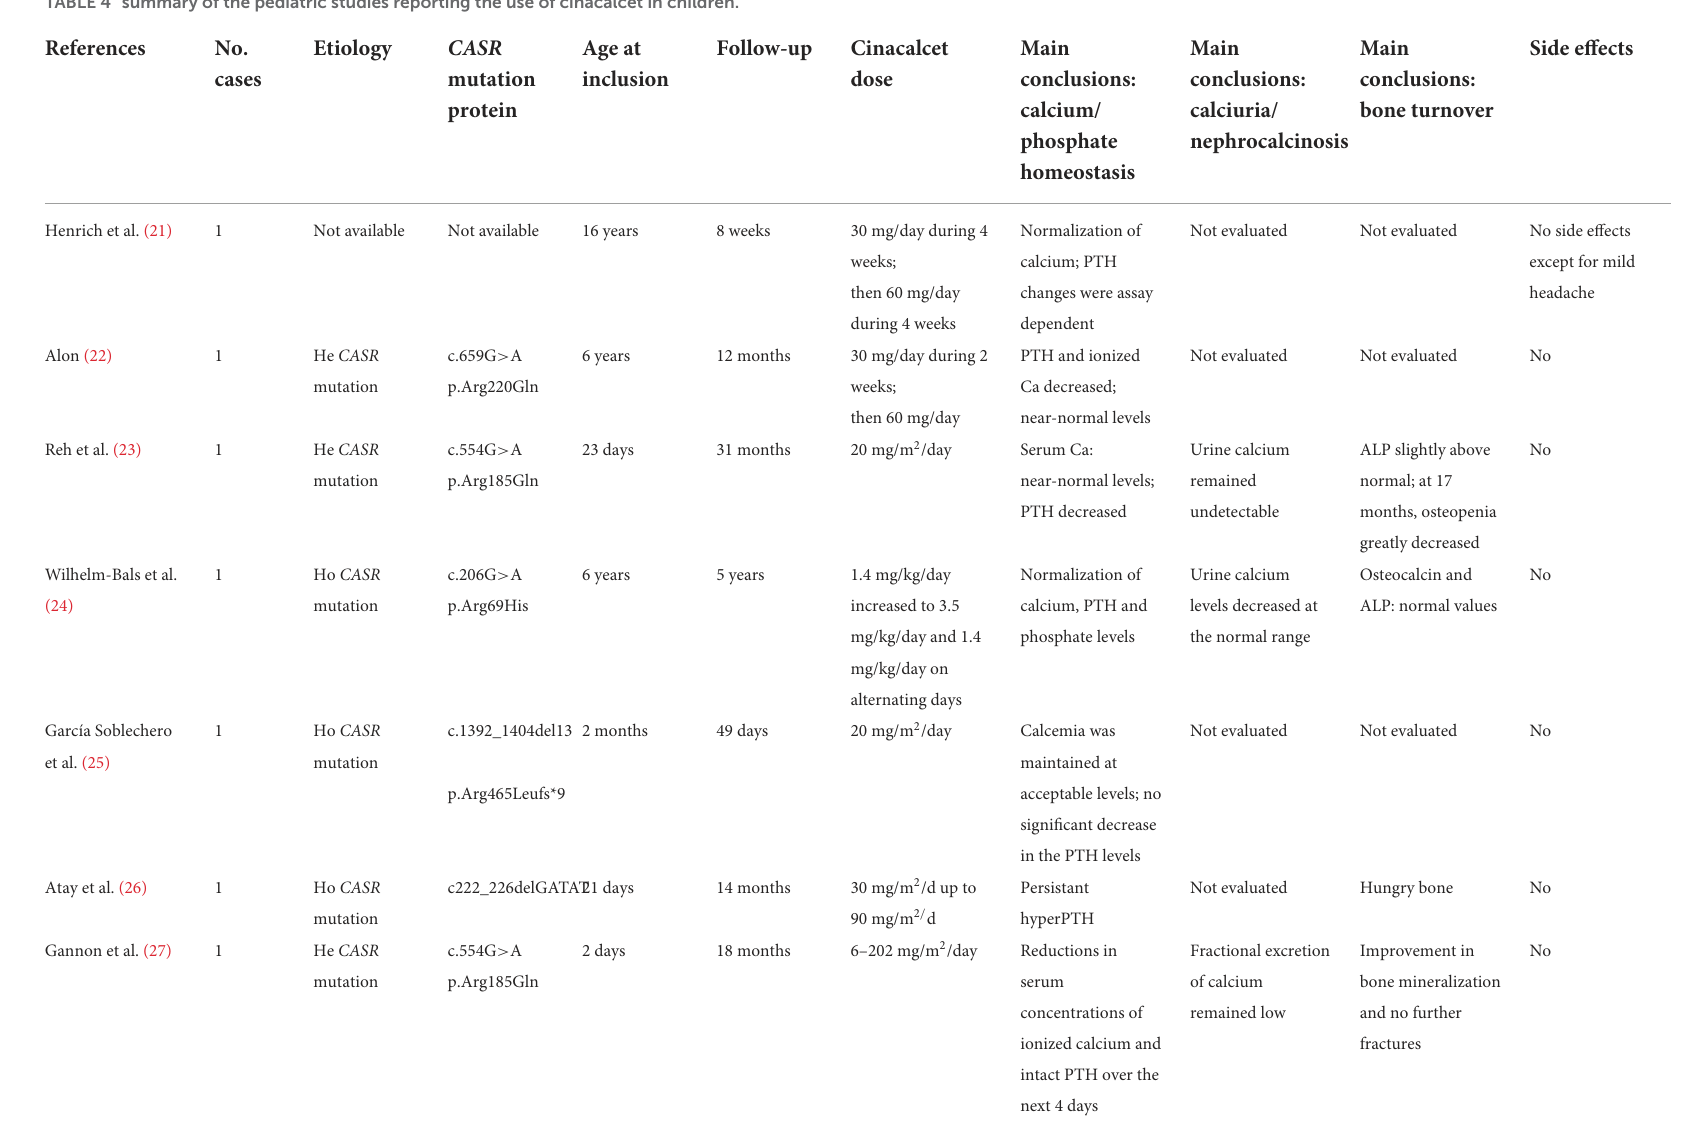
TABLE 4 summary of the pediatric studies reporting the use of cinacalcet in